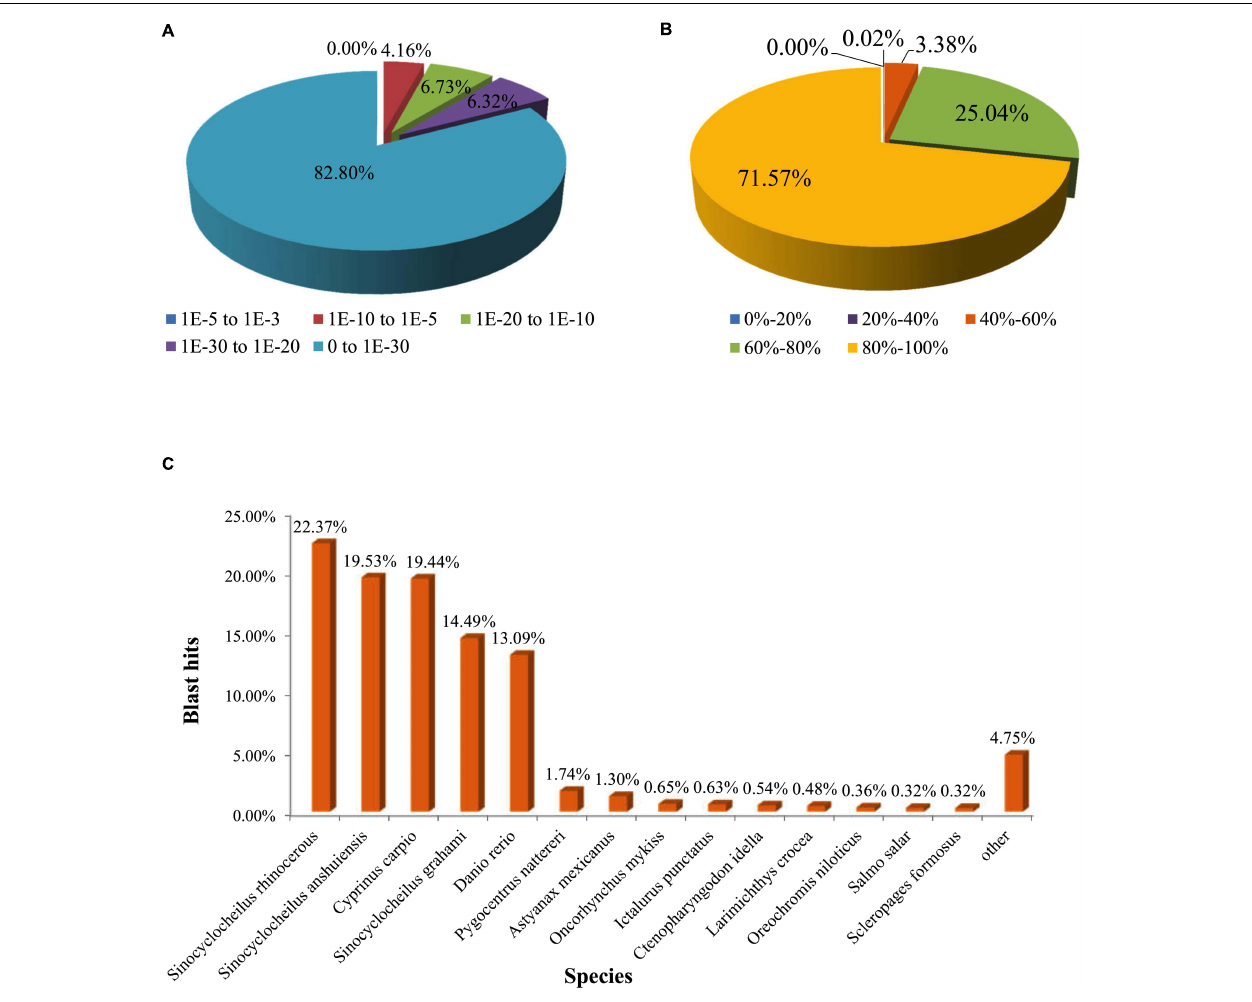
FIGURE 3 | Characteristics of homology analysis for elongate loach unigenes against the non-redundant protein database (Nr). (A) The E-value distribution of BLASTx hits for each assembled unigene. (B) The similarity distribution of BLASTx hits for each assembled unigene. (C) Species-based distribution of the top BLASTx